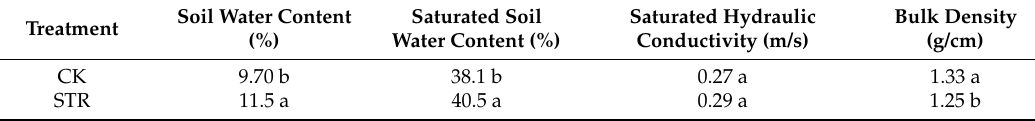
Table 2. Soil physical properties with the two treatments following the